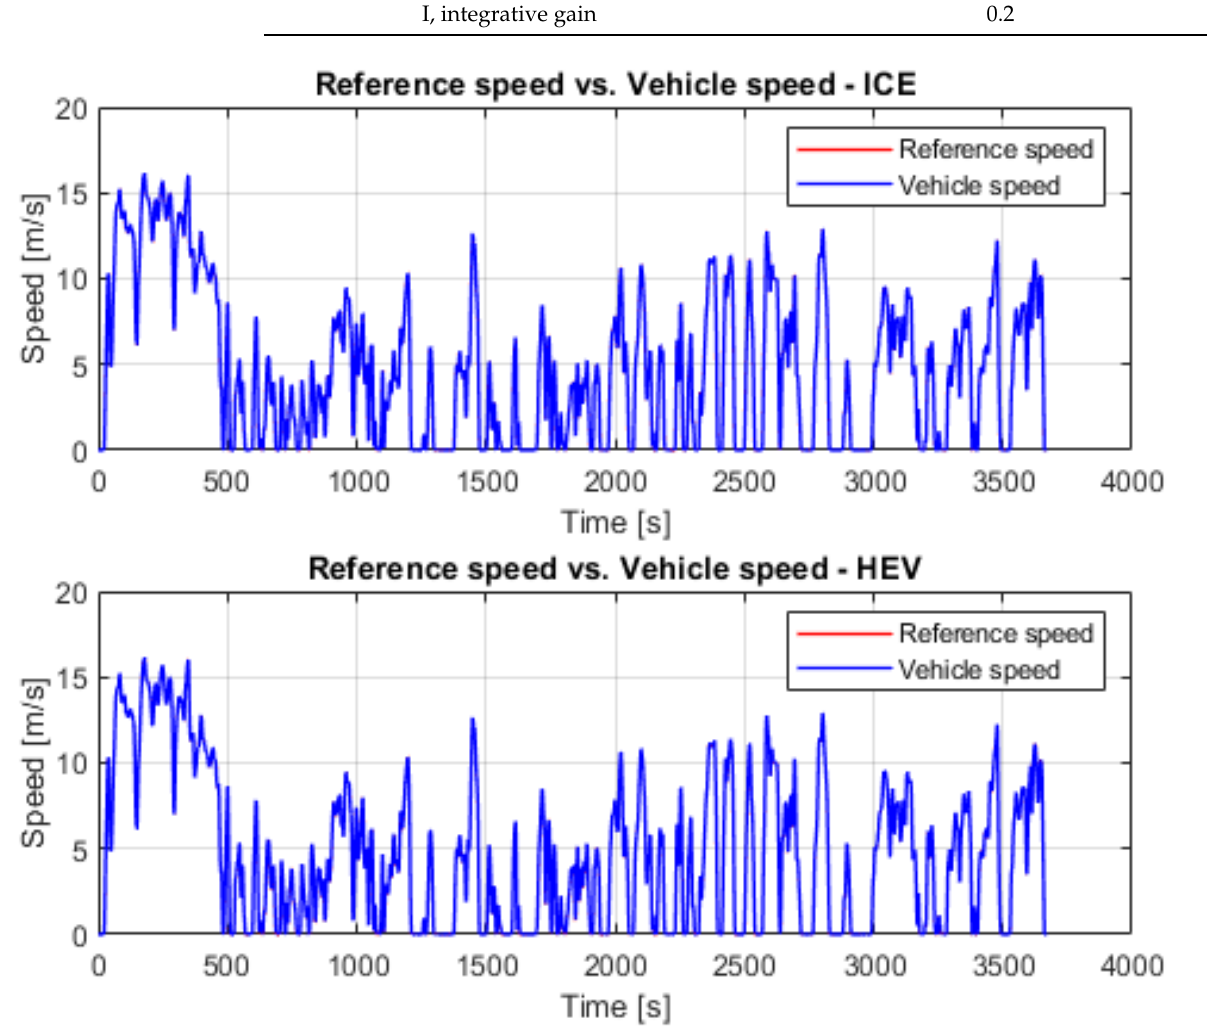
Figure 10. Comparison between reference speed and vehicle speed for both configurations.